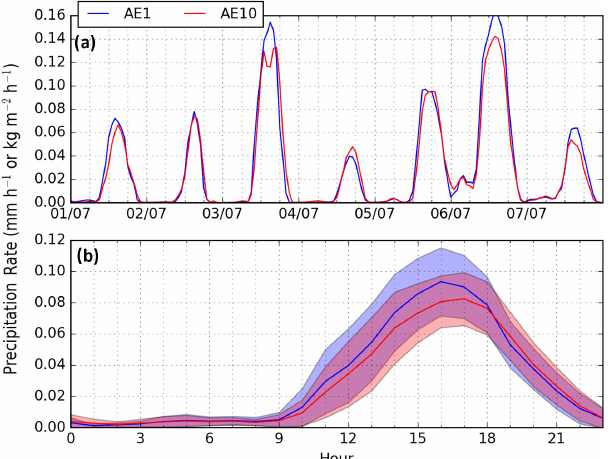
Figure 10. Time series (a) and diurnal cycles (b) of modeled hourly precipitation rate (kgm − 2 ) for the two experiments, AE1 (blue) and AE10 (red), averaged over an inland area extending from 7 to 9 ◦ N, and from 1 to 4 ◦ E for the period 1–7 July 2016. (a) The vertical dashed lines indicate periods of 6h starting at 00:00UTC. (b) Means of each hour for the period 1–7 July 2016 are presented by lines, and the upper and lower shading limits correspond to the hourly standard